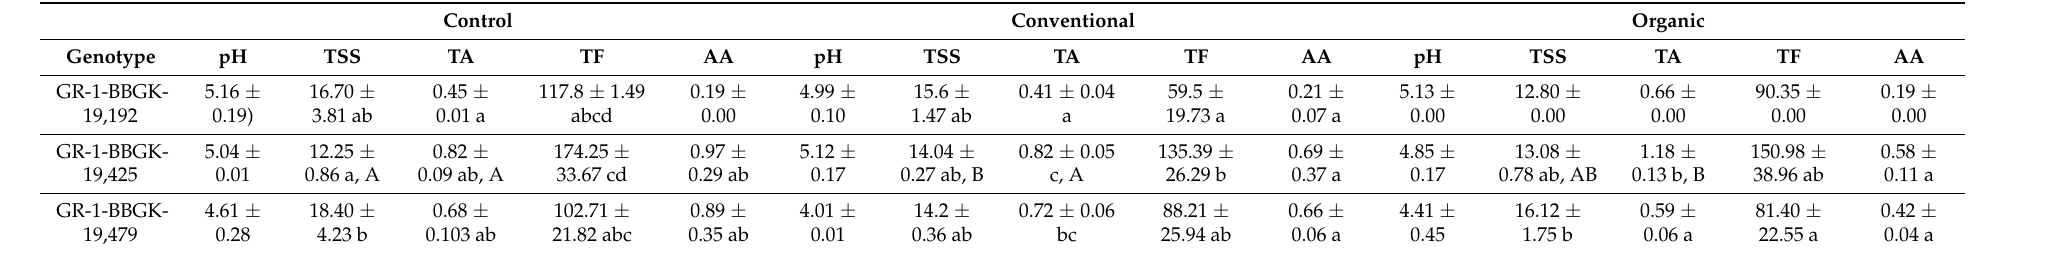
Table 4. Results of the phytochemical analyses of fruits of nine genotypes of Greek Sambucus nigra that were established in the pilot cultivation trial under conventional fertilization, organic fertilization, and control (no fertilization). The measured phytochemical attributes were total flavonoids (TF, mg catechin equivalents 100 g − 1 ) and ascorbic acid content (AA, mg ascorbic acid 100 g − 1 ), whereas the measured physicochemical attributes were pH, total soluble solids (TSS, ◦ Brix), and total acidity (TA, g citric acid 100 g − 1 ). The results are given as means ± SD ( n =